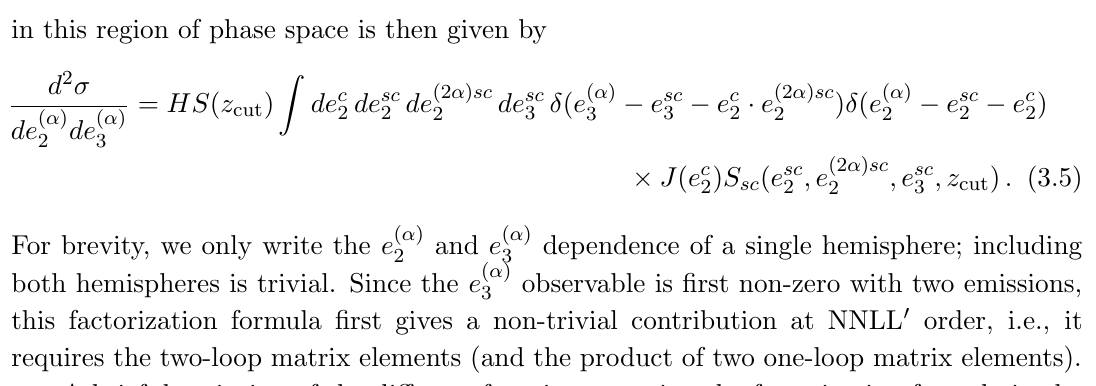
Figure 6. An illustration of the multistage matching procedure and relevant scales for the collinear- soft haze region of phase space. Because the jet and collinear-soft functions are not factorized, this is the same structure as with just measuring e ( (cid:11) ) on a groomed 2